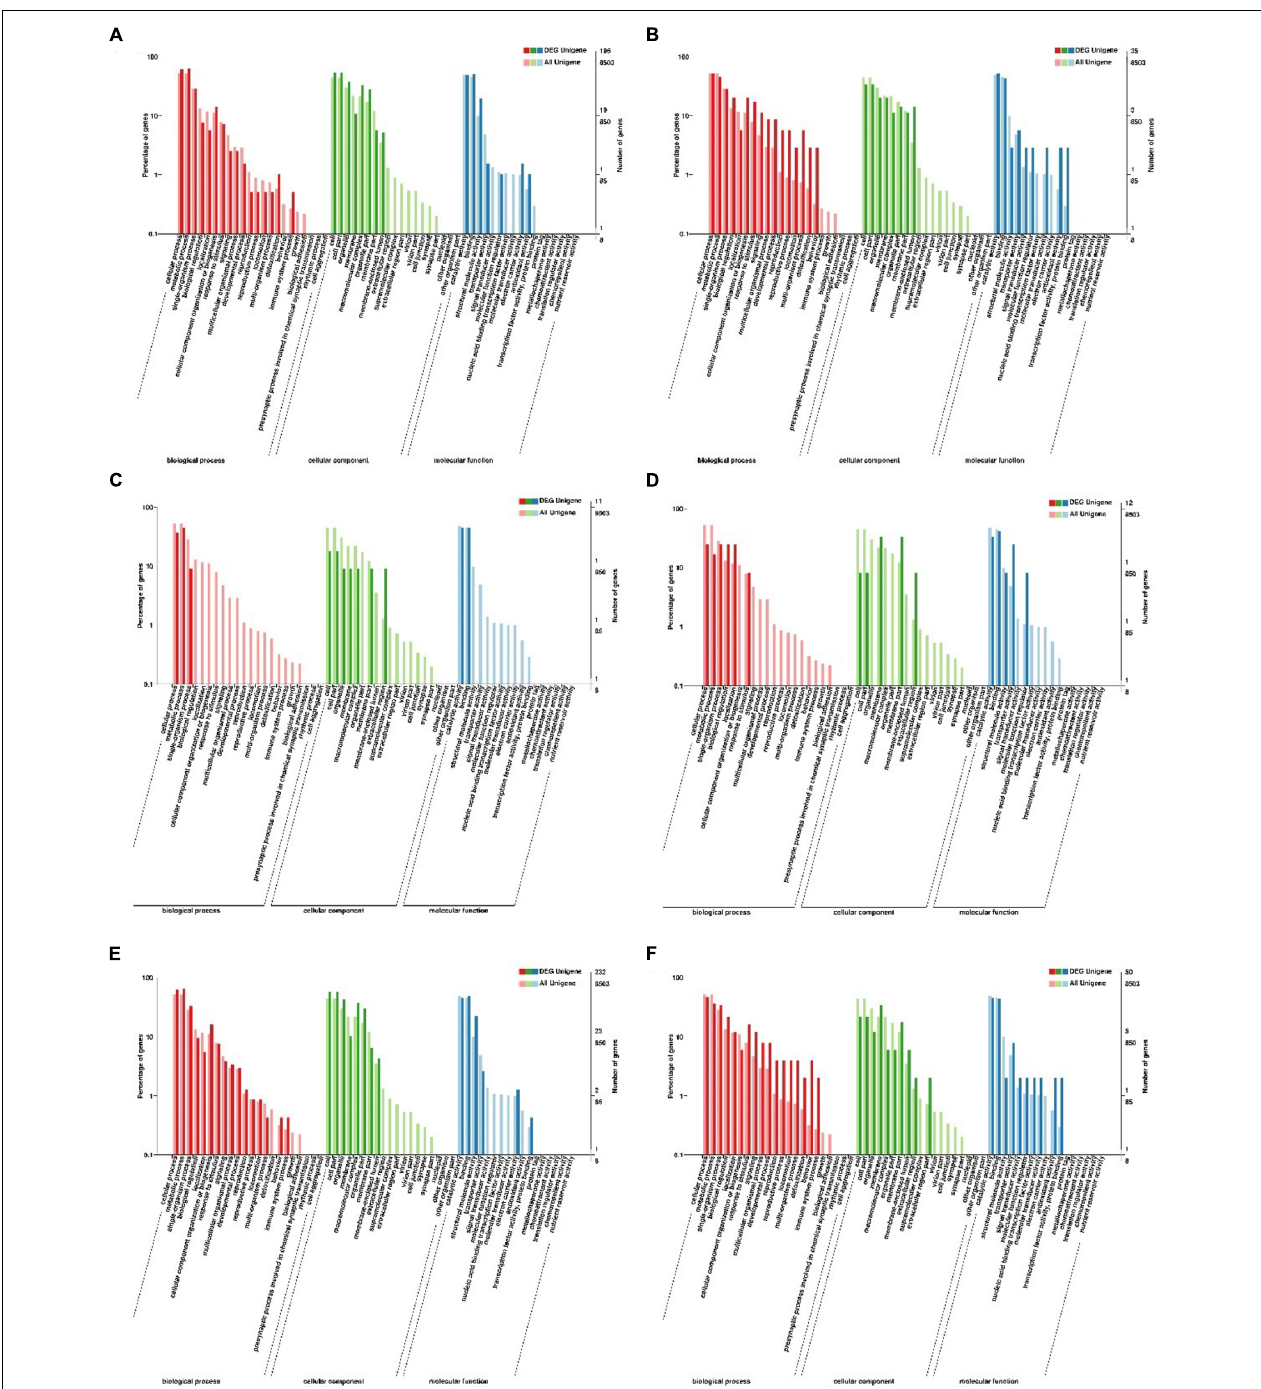
FIGURE 3 | GO enrichment analysis of the DEGs of C. japonica exposed to three temperature gradients. (A,B) Represent the GO terms of DEGs between 20 and 28 ◦ C; (C,D) represent the GO terms of DEGs between 20 and 12 ◦ C; (E,F) represents the GO terms of DEGs between 12 and 28 ◦